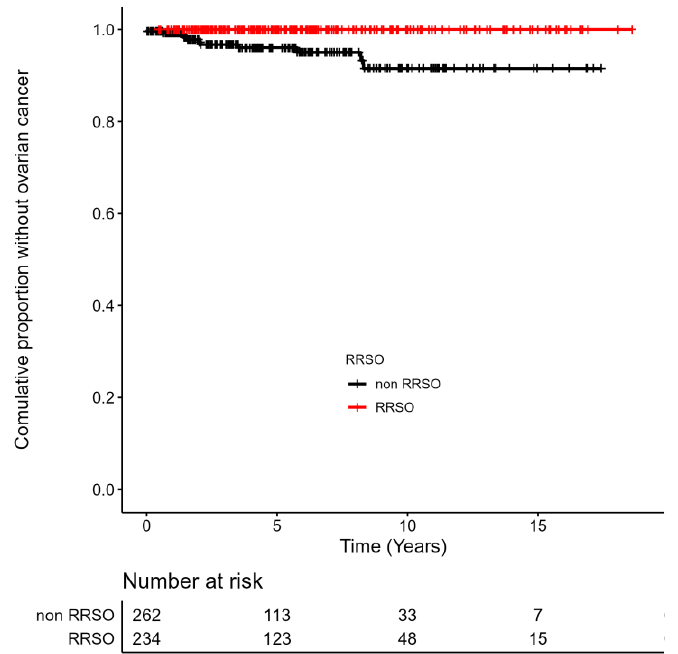
Figure 3. Incidence of Ovarian Cancer (OC) in BRCA1/2 Carriers With and Without RRSO (Kaplan- Meier Curves): In the cohort of BRCA1/2 carriers with RRSO, the time was calculated from the RRSO till the occurrence of OC or the end of the study in 2020. In the cohort of BRCA1/2 carriers without RRSO, the time was calculated from the initiation of surveillance of the woman till the occurrence of OC or the end of the study in 2020. RRSO — risk-reducing oophorectomy. A significant result was achieved; HR was not defined due to 0% occurrence of OC in the RRSO group, Log-Rank test, p < 0.001.